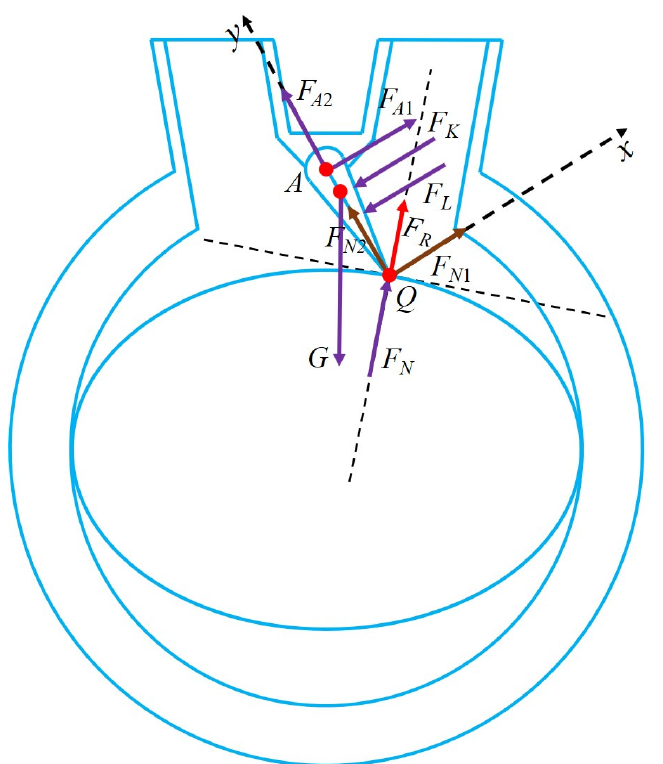
Figure 7. Force analysis diagram of the swing scraper.